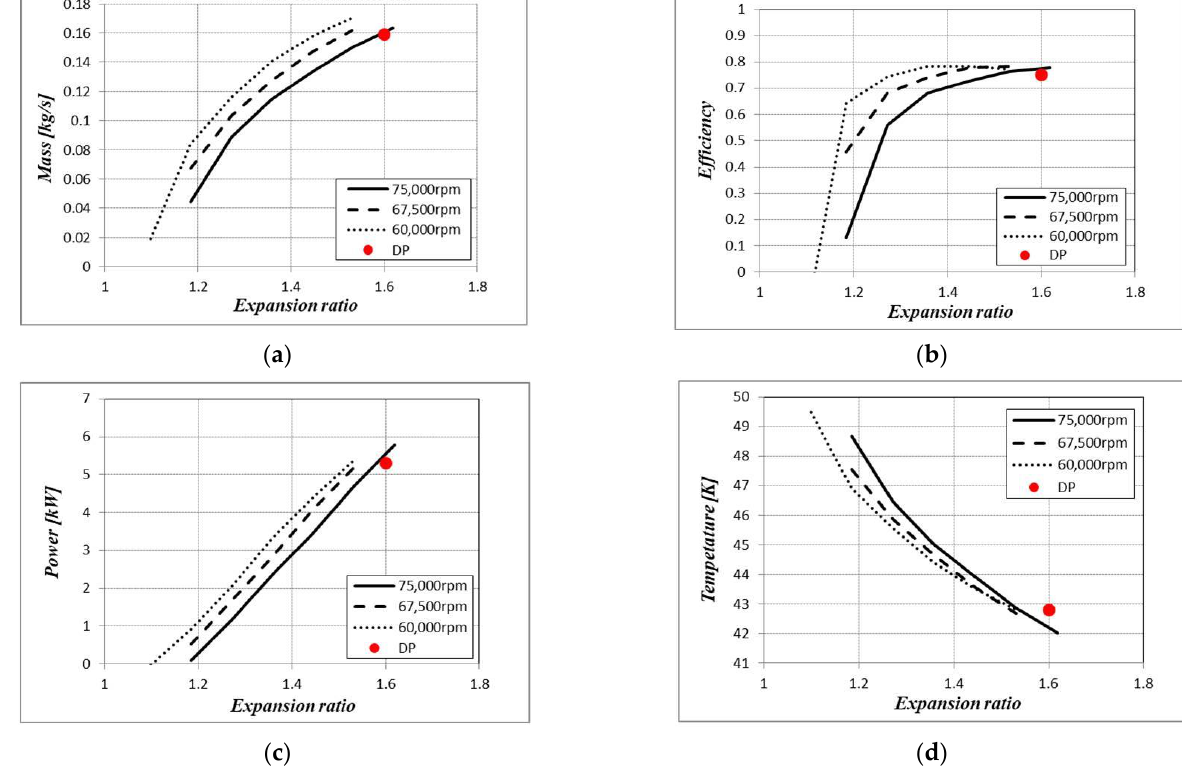
Figure 3. Velocity triangles at design points: ( a ) rotor inlet (incidence angle − 26.74°) and ( b ) rotor Figure 4. Performance prediction curves from meanline analysis: ( a ) expansion ratio vs. mass flow outlet (deviation angle 22.8°). rate; ( b ) expansion ratio vs. efficiency; ( c ) expansion ratio vs. power; ( d ) expansion ratio vs. ex- pander outlet temperature.